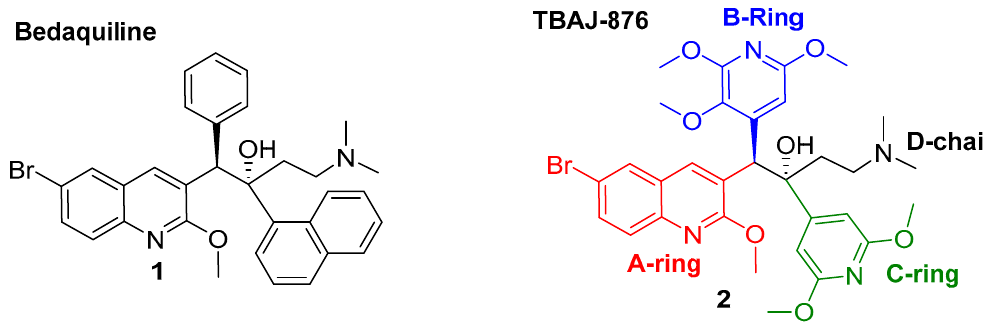
Figure 1. Structure of bedaquiline 1 and preclinical candidate TBAJ-876 2 . Table 1. Physical and biological properties of bedaquiline 1 and TBAJ-876 2 .